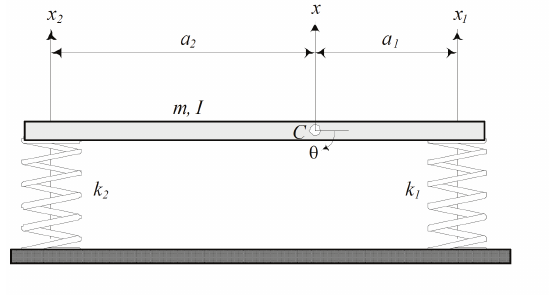
Figure 2. The bicycle model of a car is a beam of mass m and mass moment I , sitting on two springs k 1 and k 2